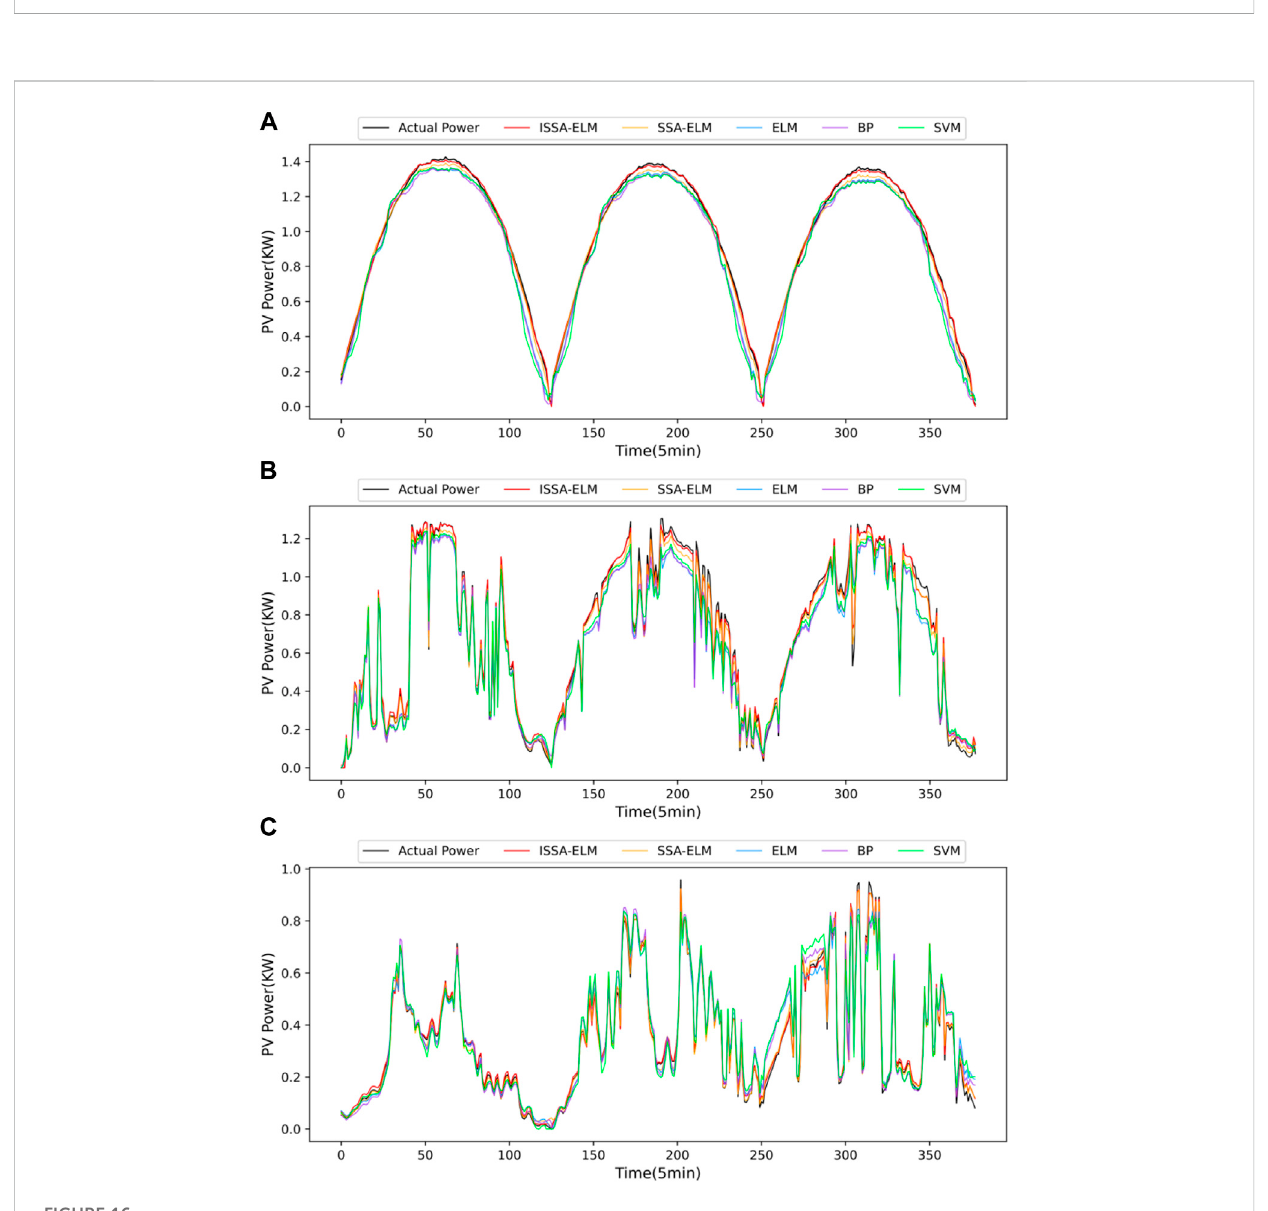
FIGURE 16 Predictions outcomes on (A) sunny days, (B) cloudy days, (C) rainy